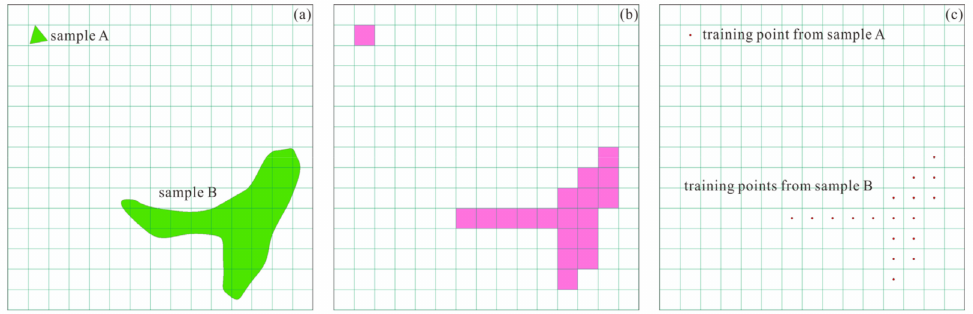
Figure 4. Improving the process of GM sample occurrence, ( a ) show the occurrence areas (vector), ( b ) are their grid form (raster), and ( c ) are the training points converted from